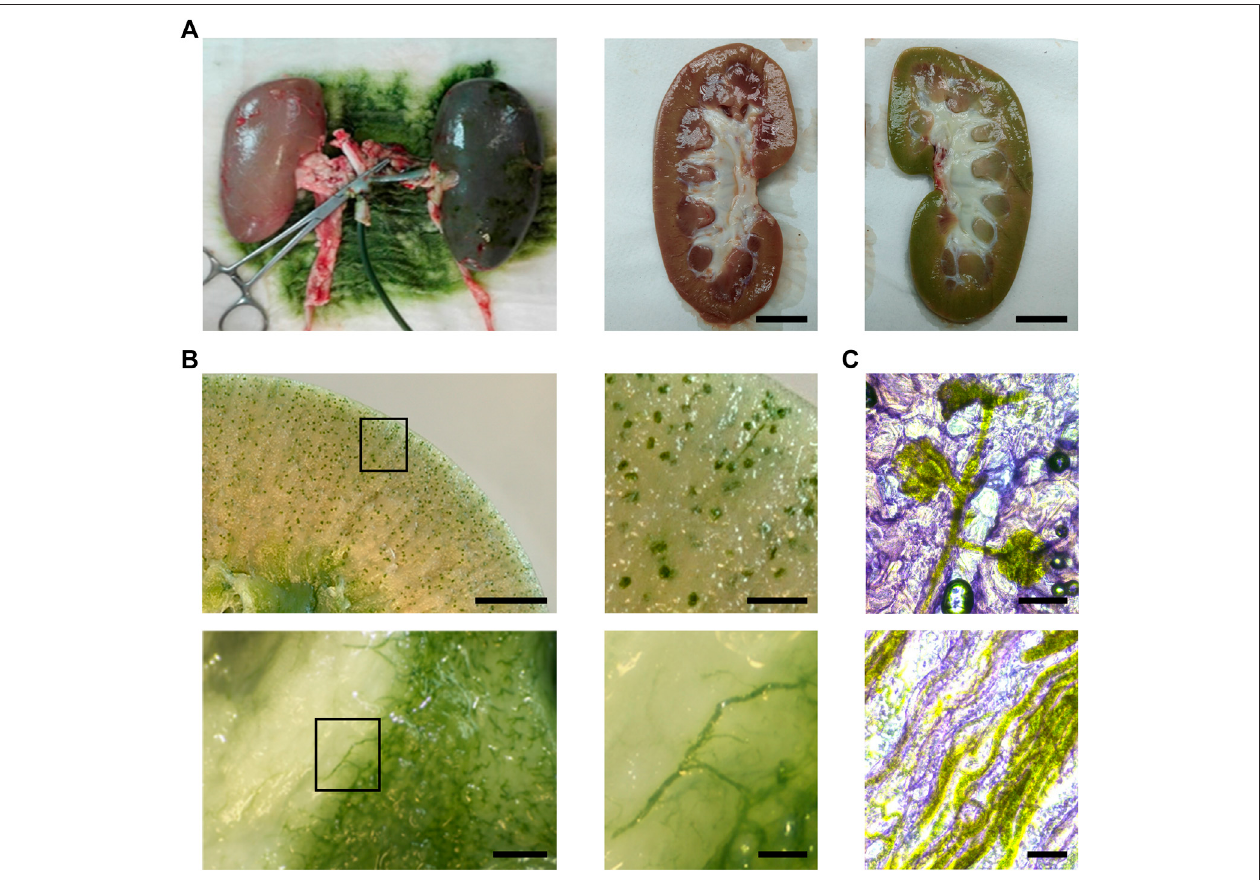
FIGURE5| Distributionofthephotosyntheticsolutioninporcinekidney.Compared tocontrols,organsturnedgreenafterperfusion[ (A) ,leftandright].Freshslices showavasculardistributionofthesolutionintherenalcortex[ (B) ,top]andmedulla[ (B) ,bottom]. Cryosections ofperfusedkidneysshowthedistributionof C.reinhardtii in glomeruli and afferent arteriole [ (C) , top] and medullar blood vessels and capillaries [ (C) , bottom]. Scale bar represents 2 cm in A, 5 mm in (B) (top, left), 1 mm in (B) (top, right) and (B) (bottom, left), 250 µm in (B) (bottom, right), 100 µm in (C) .